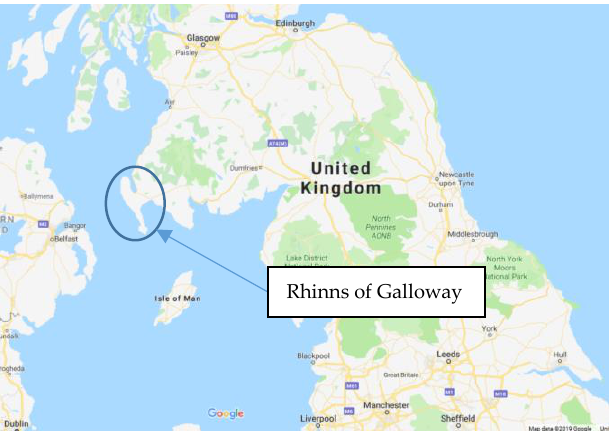
Fig. 8. The Scottish southwest coastline, as it is in reality.